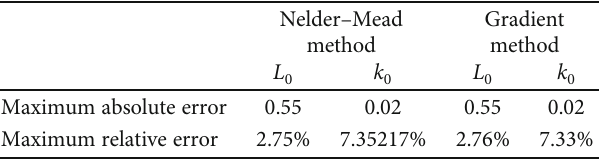
Figure 1: Functions L ð t Þ and C ð t Þ calculated with exact values of L Table 2: Results of calculations with an error α = 5 % .